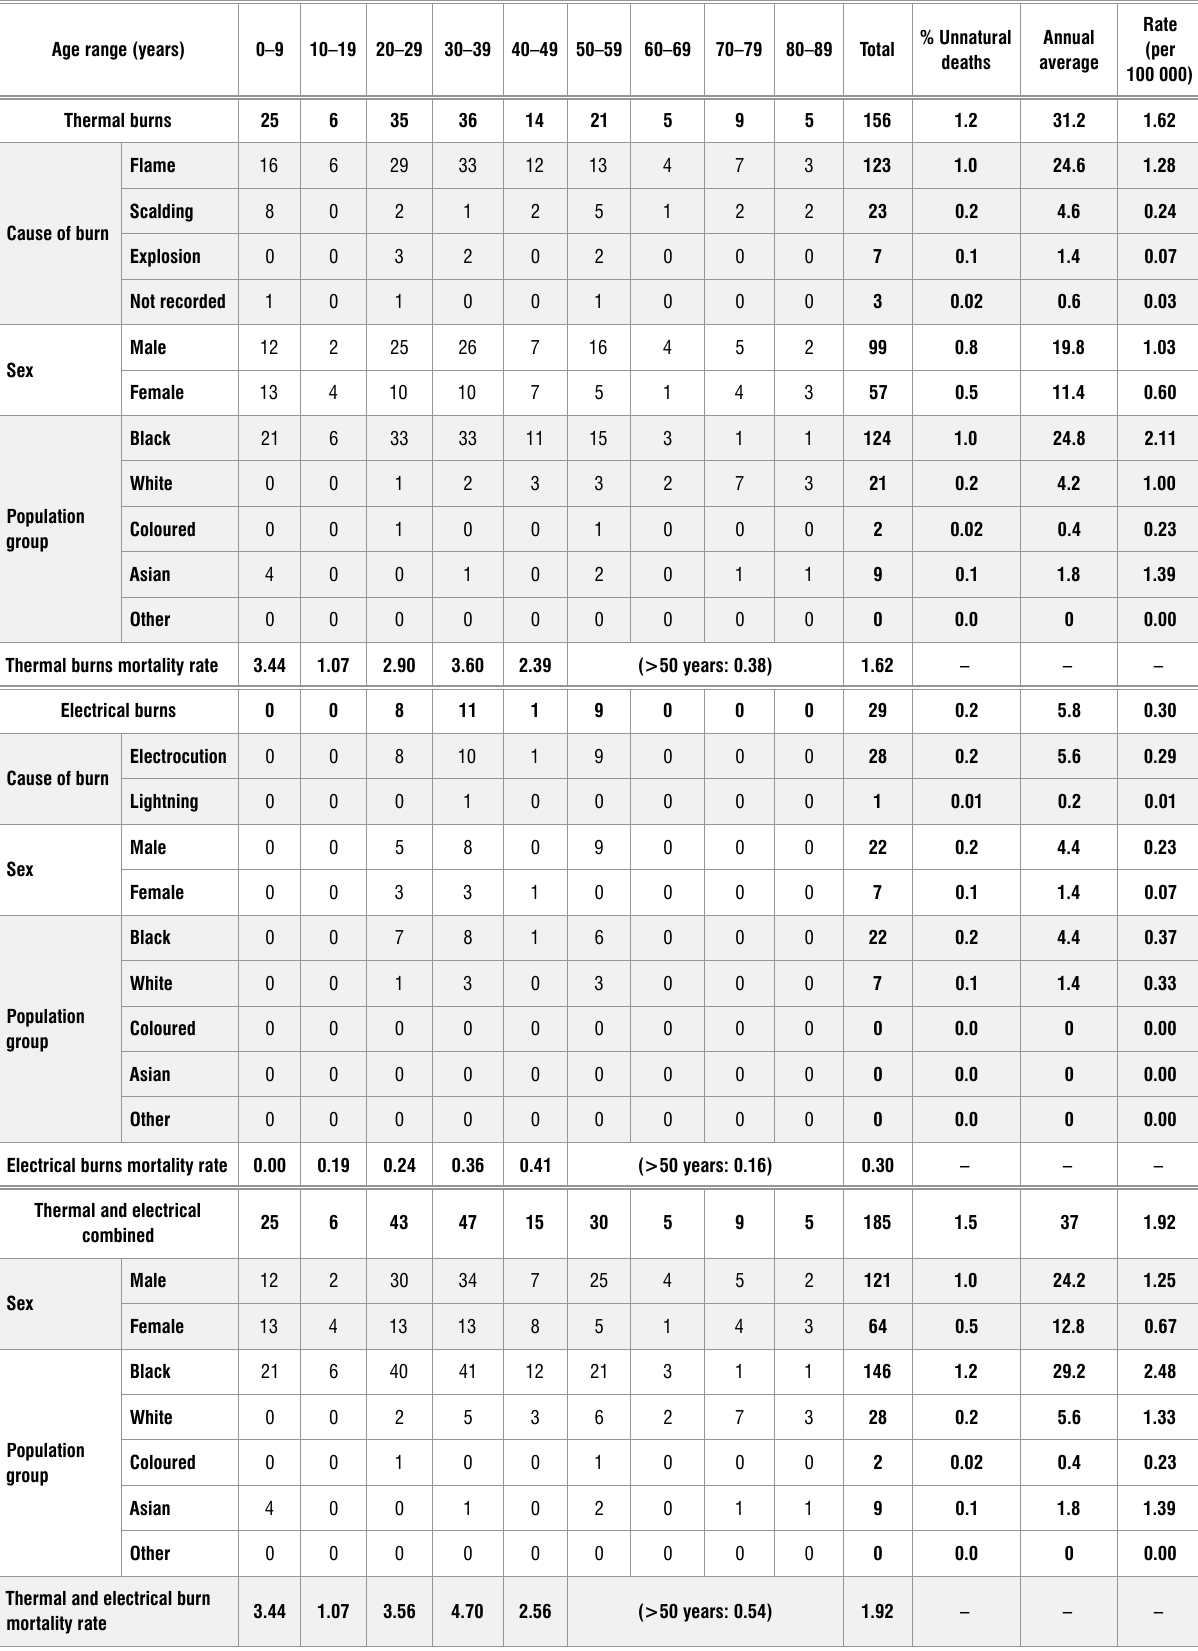
Table 1: Population and sex breakdown of the incidence of burn mortalities (per 100 000) in Johannesburg from 2010 to 2014